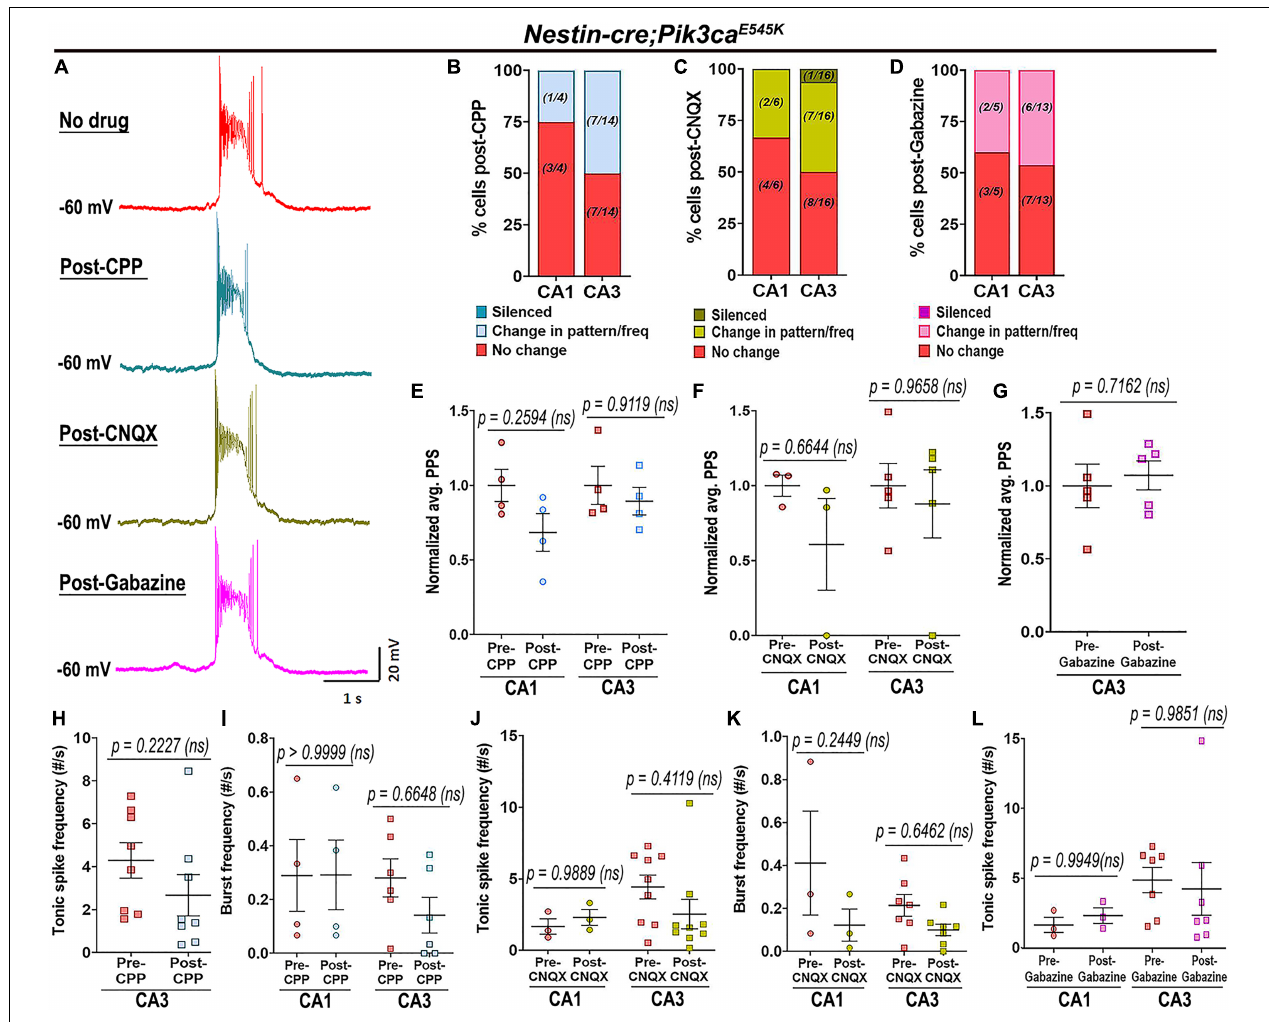
FIGURE 4 | Pik3ca-related epileptiform activity is not dependent on glutamatergic or GABAergic inputs. (A) Representative spontaneous mutant trace and traces of the same cell post-treatment with glutamatergic receptor antagonists (CPP, CNQX) and with GABA antagonist gabazine showed no significant change in firing pattern. (B–D) Large proportion of mutant cells remained unaffected after being blocked from external glutamatergic or GABAergic inputs. (E–L) No significant differences in normalized plateau potential shift (PPS; CPP: F = 3.391, df = 12; CNQX: F = 1.432, df = 12; Gabazine: t = 0.3904, df = 4) or in tonic (CPP: t = 1.876, df = 7; CNQX: F = 0.2766, df = 20; Gabazine: F = 0.0001130, df = 16) and burst frequencies (CPP: F = 0.5140, df = 16; CNQX: F = 5.218, df = 16) were observed before and after administration of channel blockers. Data is represented as % bar graphs and mean ± SEM scatter plots; differences were considered significant at p < 0.05; ns, not significant. Scale bar: 1 s, 20 mV (A)